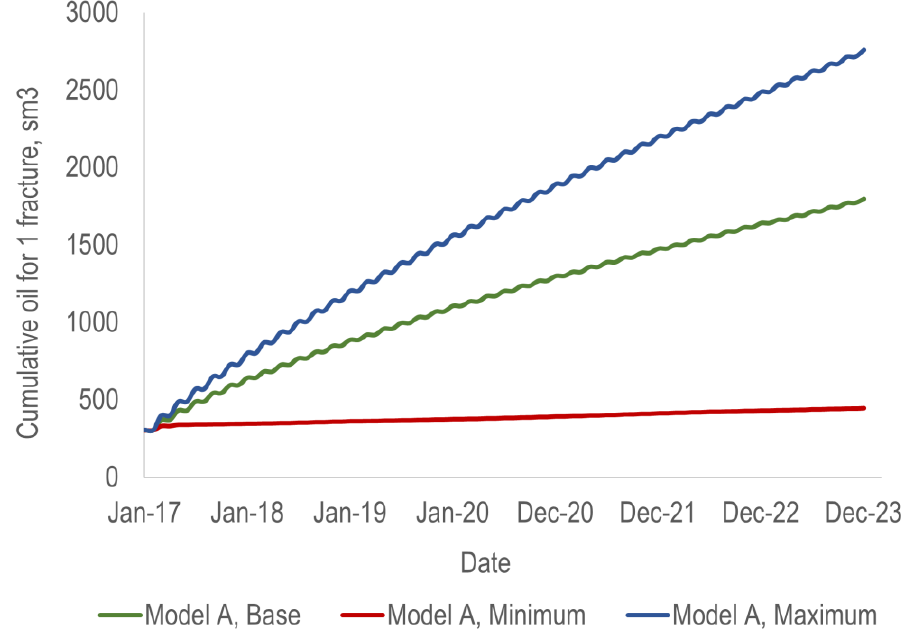
Figure 6. Effect of injected gas composition on cumulative oil